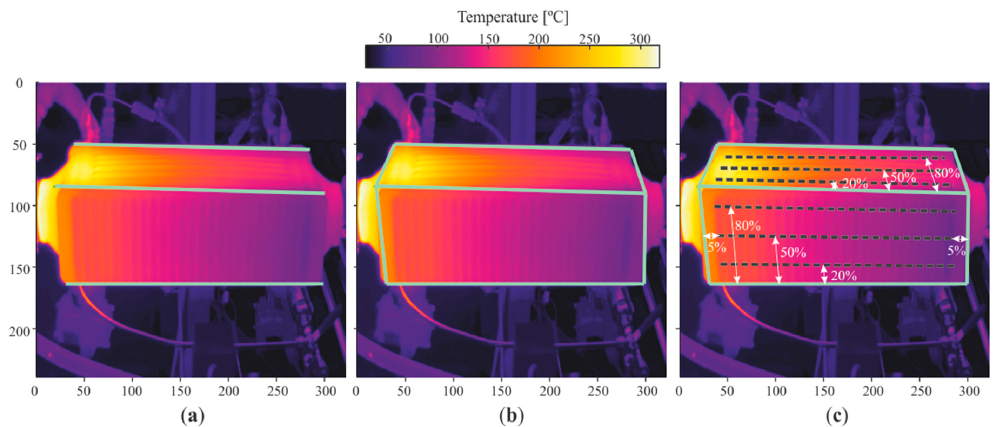
Figure 8. Walls detected by the developed methodology: ( a ) main edges detected, ( b ) walls of interest, ( c ) studied path positions.